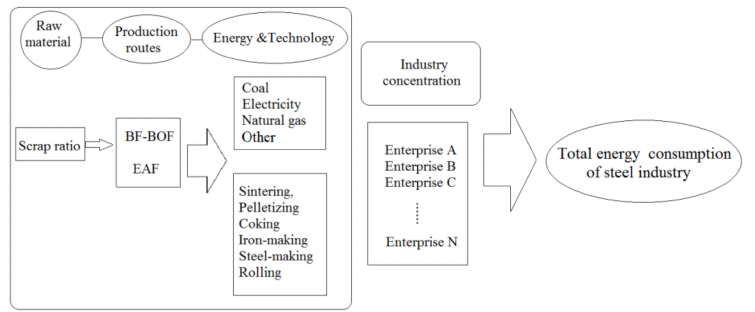
Figure 1. Structure of impact factors that influence on energy intensity (EI) on China’s steel